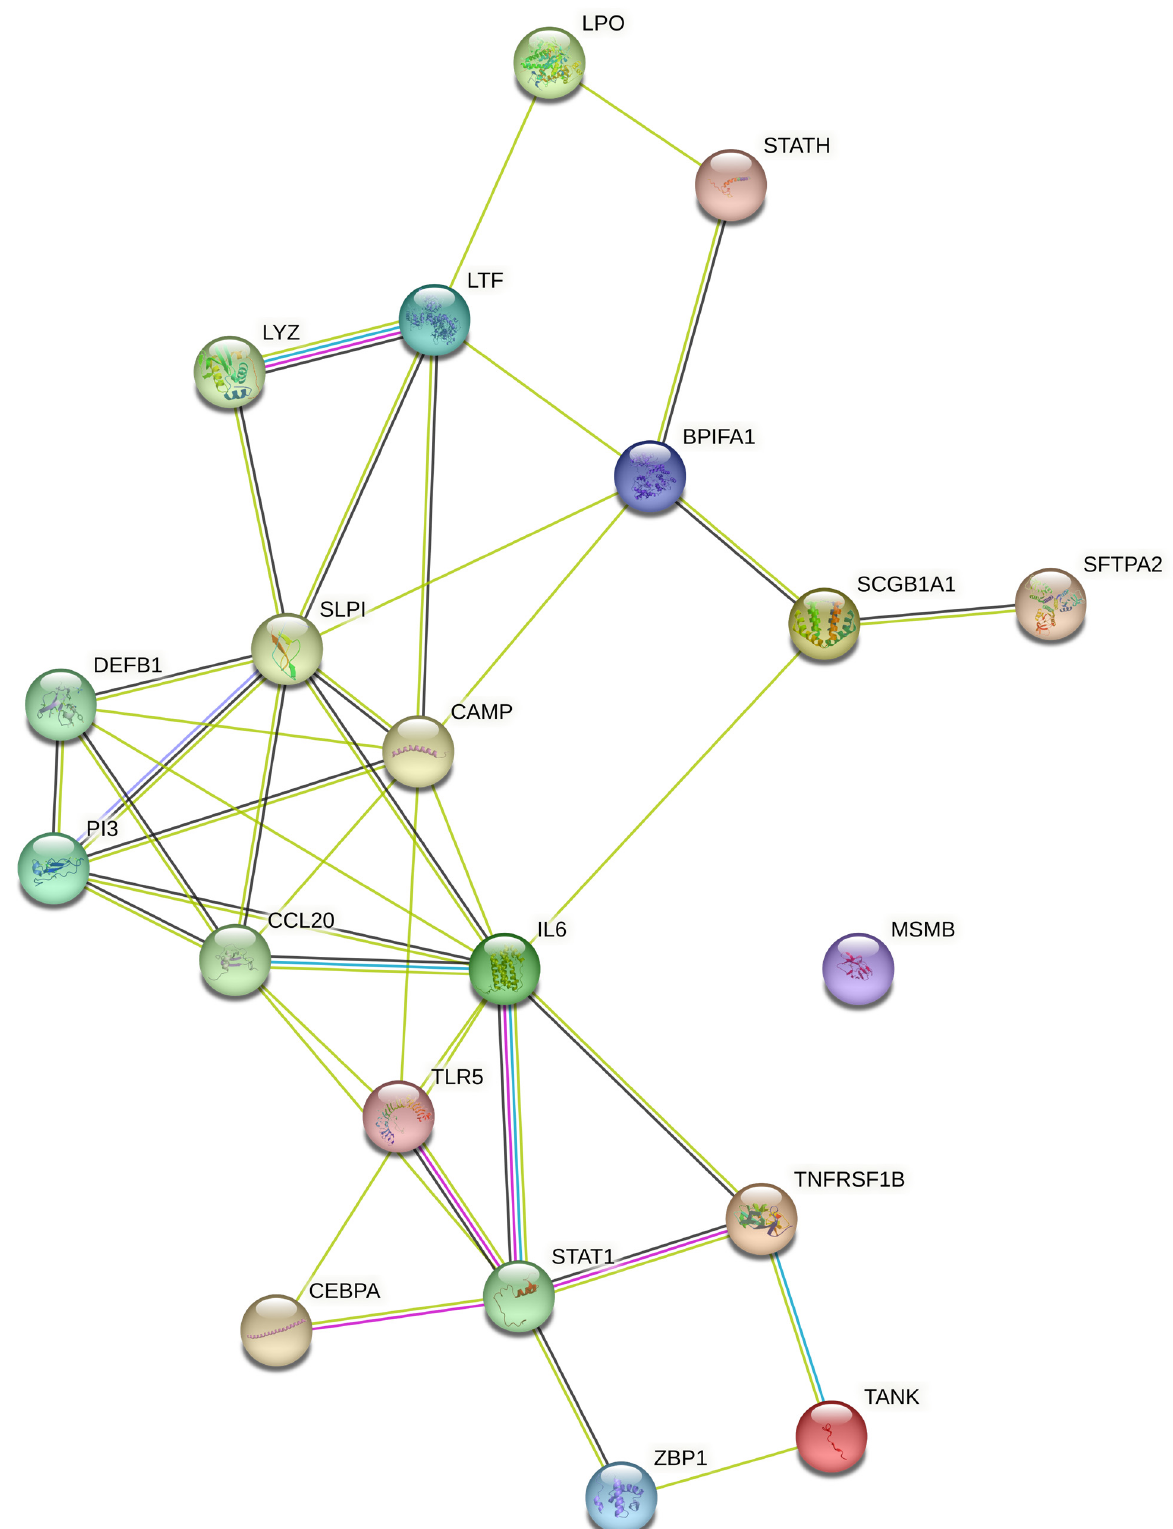
Figure 4. Protein–protein interaction network generated using STRING database. Different-colored circles represent the different antimicrobial peptides while connecting lines represent various interactions between the studied AMPs. Peptide shows more than one type of interaction connected with multiple lines respectively.